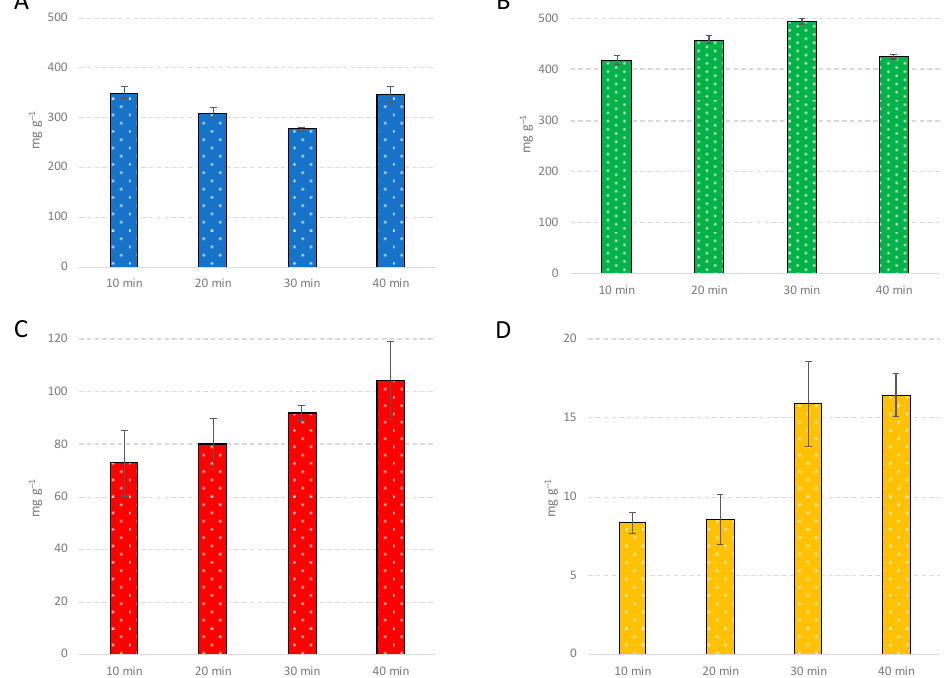
Figure 1. Level (mg g − 1 ) of monoterpenes ( A ), sesquiterpenes ( B ), oxygenated compounds ( C ) and cannabinoids ( D ) obtained using different time periods of distillation at 700 W: 10 min, 20 min, 30 min and 40 min.